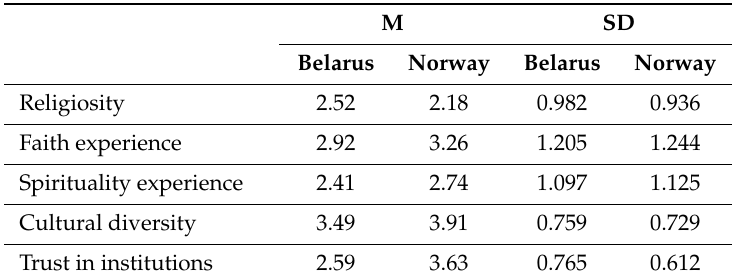
Table 3. Scales (Means and standard